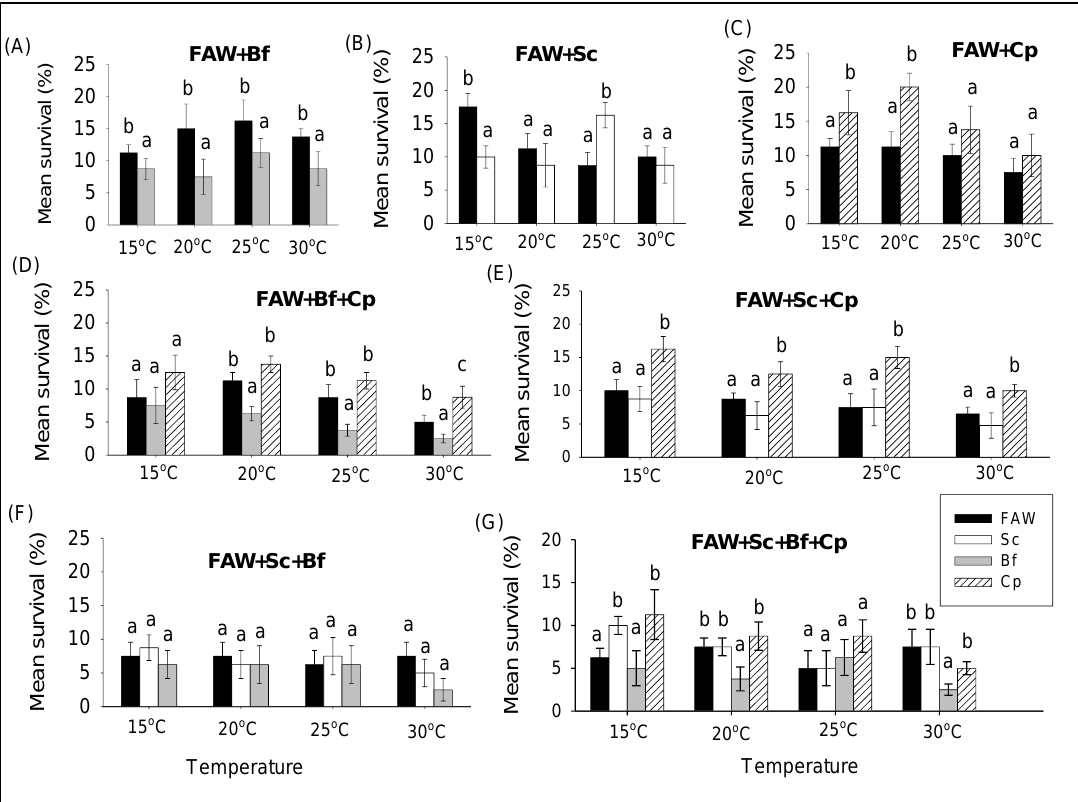
Figure 3. Comparison of survival of S. frugiperda (FAW), B. fusca (Bf), S. calamistis (Sc), and C. partellus (Cp) in multi-species combinations at different constant temperatures. Means (±SE) with different letters are significantly different, determined using Tukey’s multiple comparisons tests performed with lsmeans R package [21], following generalized linear model (GLM) with simple binomial procedure. A = FAW+Bf, B = FAW+Sc, C = FAW+Cp, D = FAW+Bf+Cp, E = FAW+Sc+Cp, F = FAW+Sc+Bf, G = FAW+Sc+Bf+Cp.